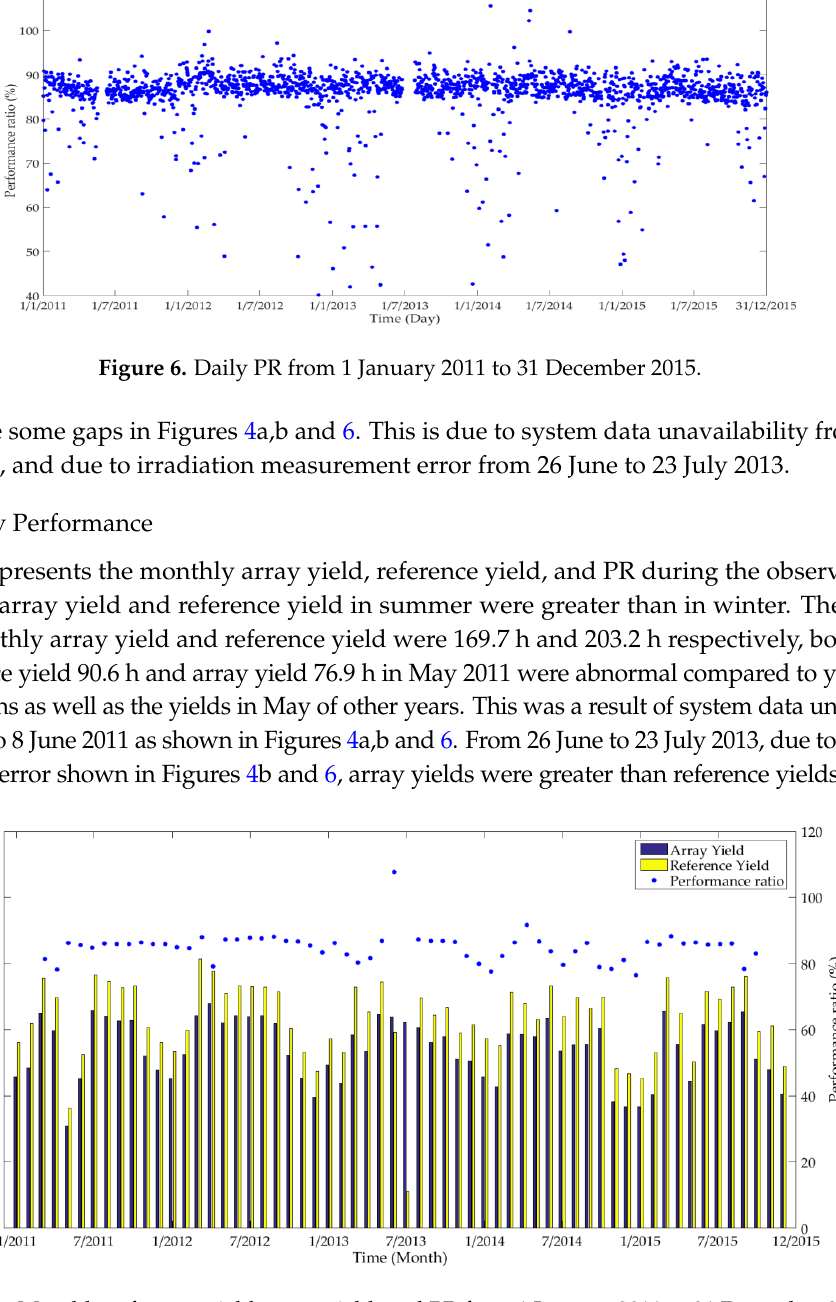
Figure 7. Monthly reference yield, array yield, and PR from 1 January 2011 to 31 December 2015.